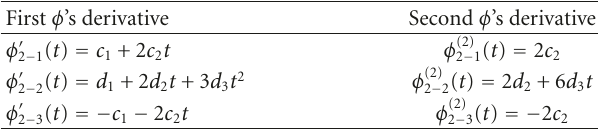
Table 1: Expressions of the first and second phase